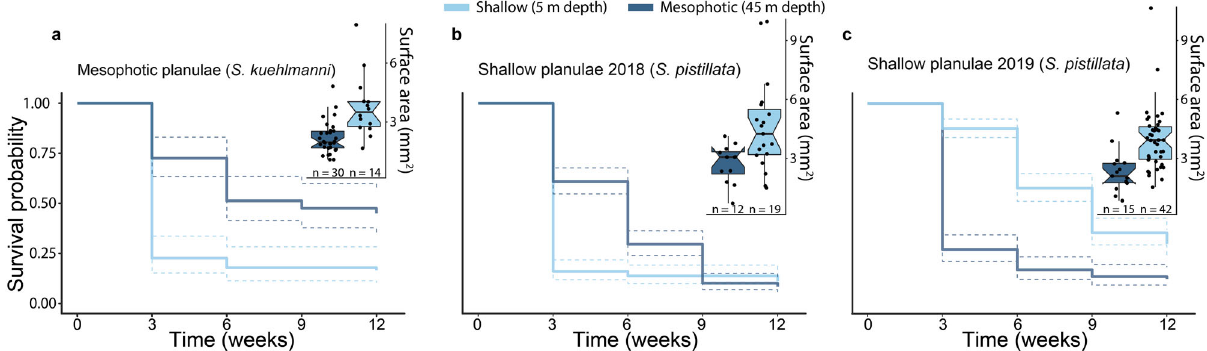
Fig. 3 Survival and growth of juvenile coral settlers translocated to shallow and mesophotic depths. Kaplan – Meier survival curves of coral settlers originated from a mesophotic-reef Stylophora kuehlmanni larvae ( n = 84 and 80 for the shallow and mesophotic translocations, respectively); b shallow-reef Stylophora pistillata larvae in 2018 ( n = 218 and 217 for the shallow and mesophotic translocations, respectively); and, c shallow-reef S. pistillata larvae in 2019 ( n = 198 and 178 for the shallow and mesophotic translocations, respectively). Dashed lines indicate 95% con fi dence interval. Box plots in each panel show the size of the surviving corals at the end of each experiment (as the data points), with center lines indicating the medians, boxes indicating the lower and upper quartiles, and whiskers indicating 1.5x interquartile range. Signi fi cant differences in the survivorship and growth between depths were found in